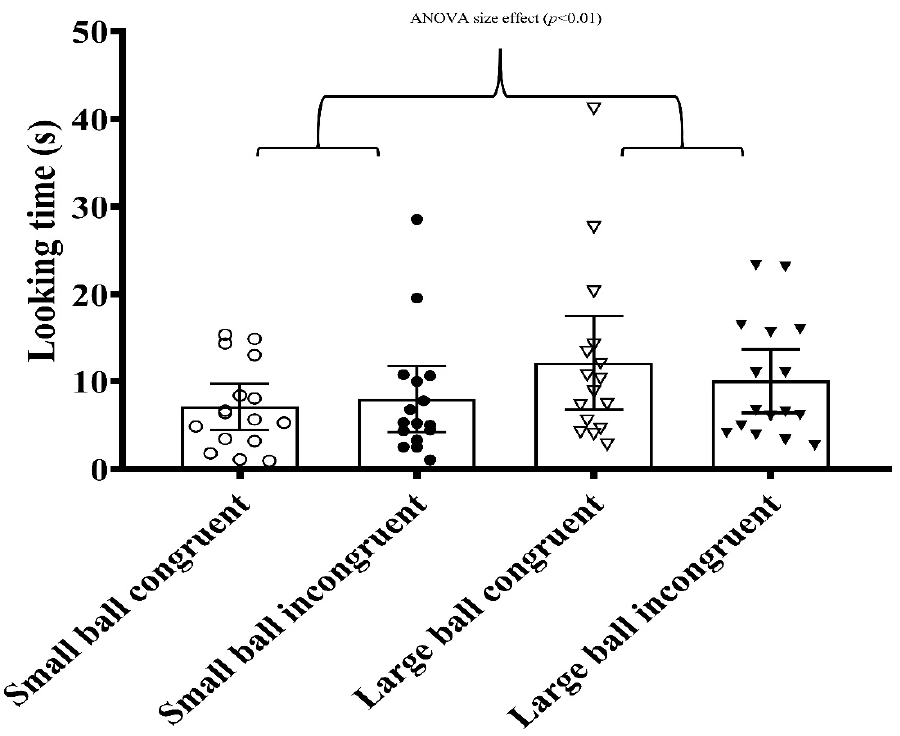
Figure 3. Looking time for small and large ball congruent and incongruent test events. Data are presented as grouped dot plots and mean and 95% confidence intervals. AU = arbitrary units.